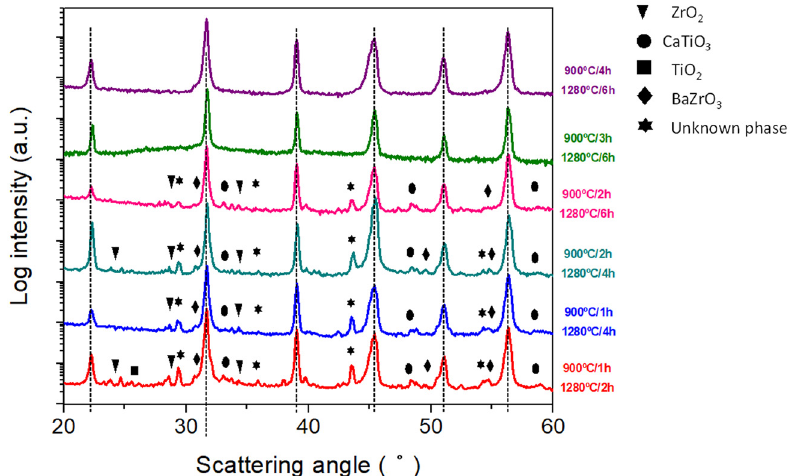
Figure 6. XRD diffraction patterns of the sintered ceramics after synthesis at 700 ◦ C 2 h using a two-step sintering method at different sintering times and temperatures. Vertical dotted lines indicate the main BCZT perovskite reflections. Symbols indicate the secondary phases that accompany the main BCZT perovskite.